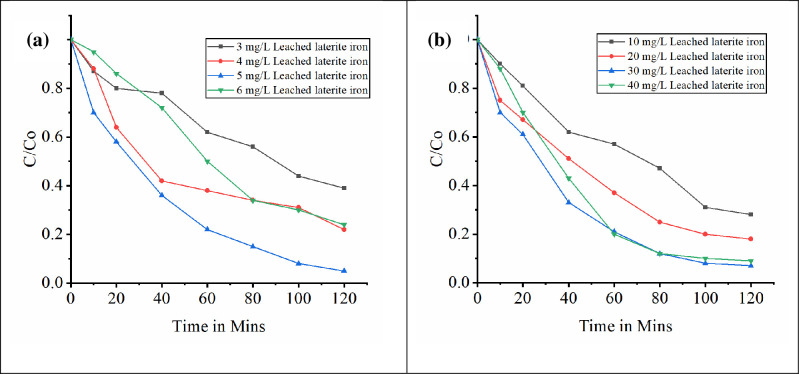
Degradation of target compound at different iron loading for a) Ametryn at 50 mg/L H2O2 b) Dicamba at 300 mg/L of H2O2.